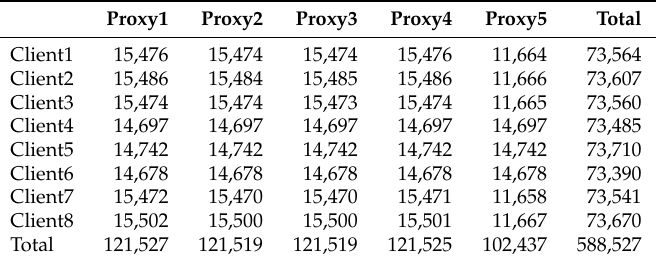
Table 3. Number of measurements of response time actually collected for each client/proxy